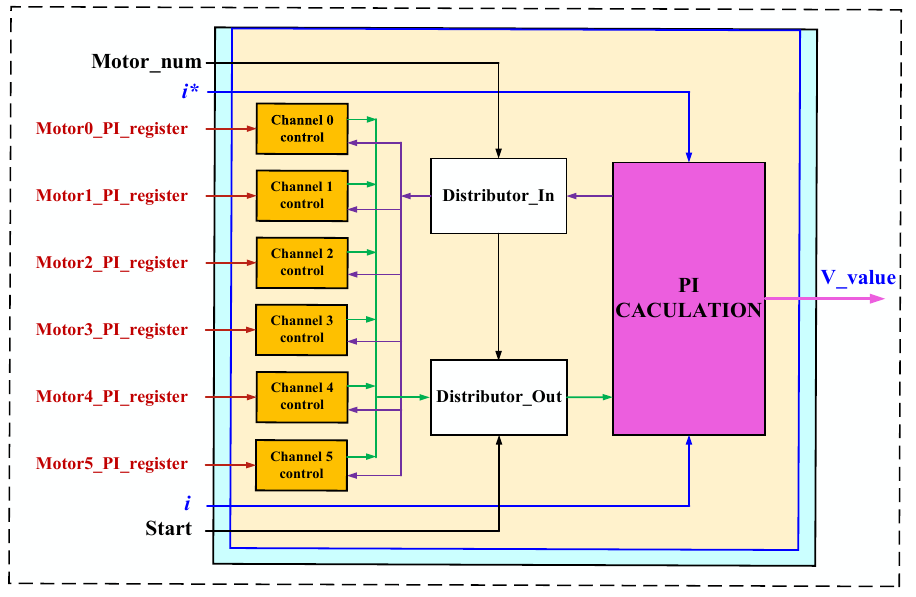
Figure 8. Structure of PI control unit.